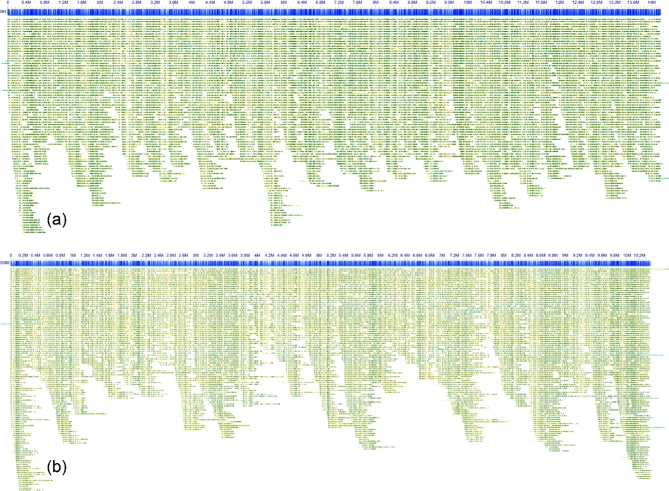
Assembled physical map. The physical maps were assembled and extended based on the similarity and overlap of molecules. The blue bars indicate the physical map and the green bars indicate the molecules. In the absence of amplification, the molecule coverage of each part of the physical map is very uniform. a and b are physical map examples of M. pentadactyla and M. javanica, respectively